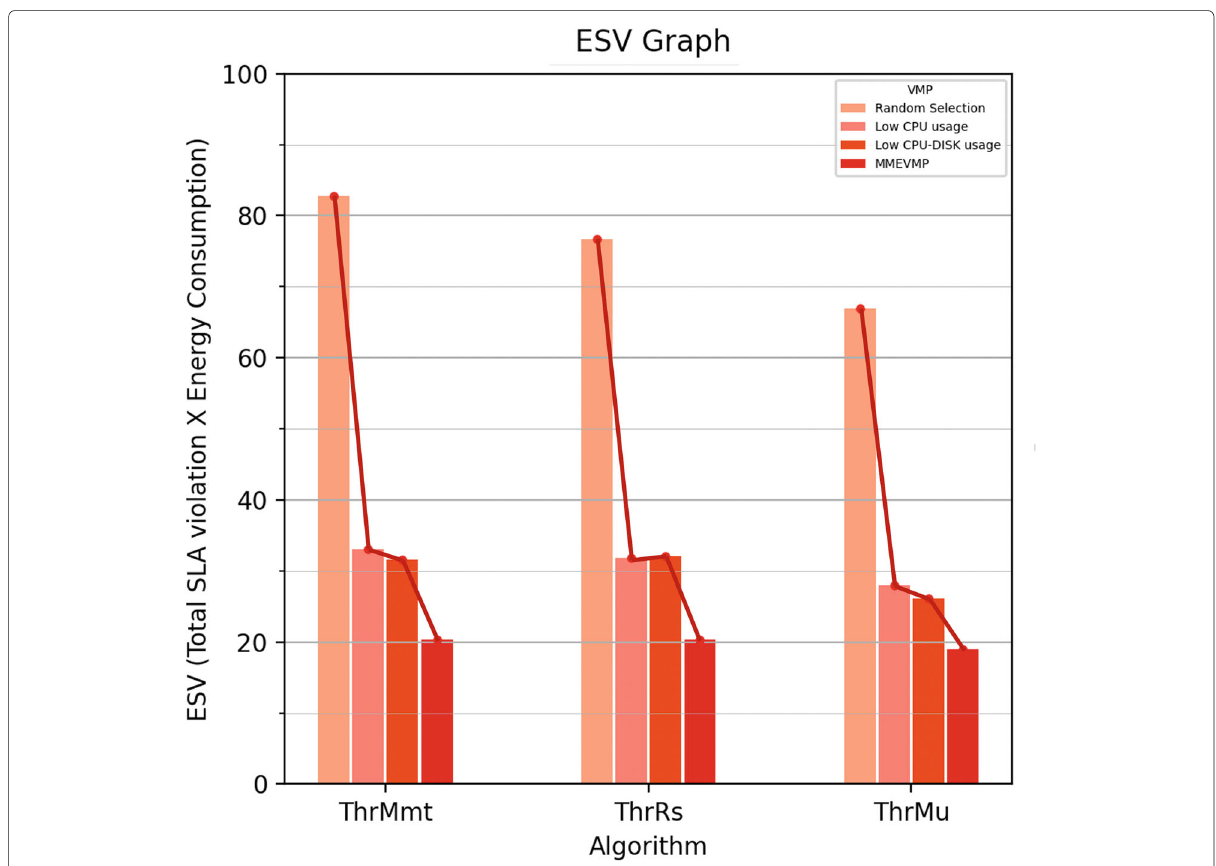
However, since our strategy was designed to focus on a specific environment, there may be limitations when calculating ADT values or tolerances and it may not be suitable for all cloud environments. Neverthe- less, the amount of data analysis job is on the rise, and in an environment where such data-intensive job is dominating, our proposed strategy will be sufficiently